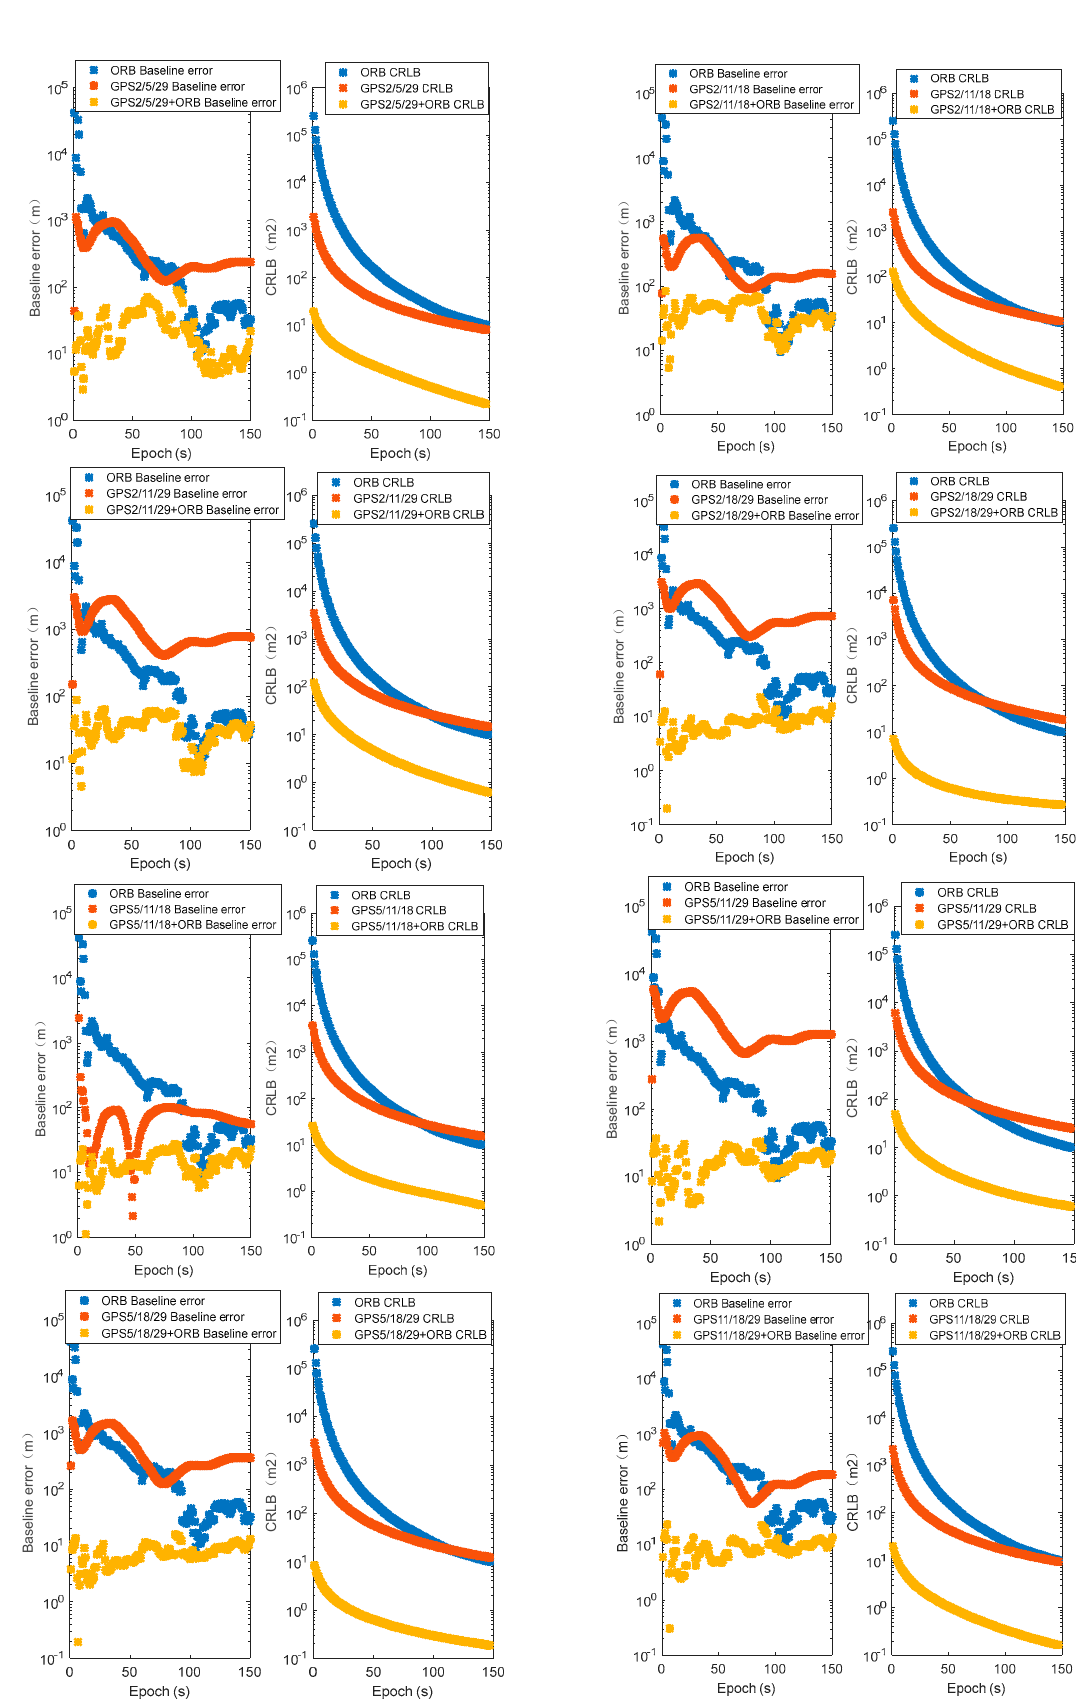
Figure 12. Baseline errors and CRLB in epoch accumulation for di ff erent satellite combinations. By comparing the CRLB, the convergence speed and error variance of 3 GPS+2 Orb- comm epoch accumulation were be tt er than those of other schemes. Furthermore, with